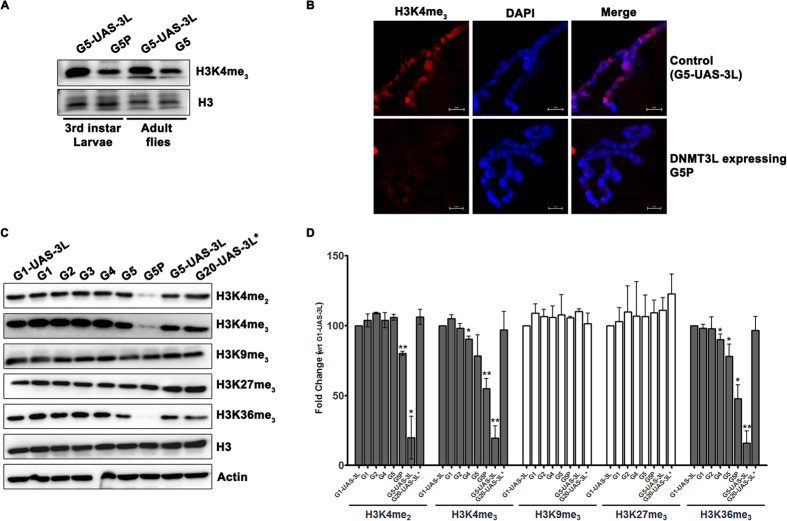
Accumulation of aberrant histone methylation in DNMT3L expressing Drosophila across successive generations.(A) Western blot analysis demonstrating decrease in the levels of the H3K4me3 in 3rd instar larvae or adult flies expressing DNMT3L from the 5th generation as compared to control UAS-3L flies lacking the GAL4 driver. Histone H3 was used as loading control. (B) Immunostaining of Drosophila polytene chromosomes with H3K4me3 antibody. (C) Western blot analysis for the various histone modification as indicated, performed on larvae from the various generations of control and DNMT3L expressing Drosophila larvae. The densitometric scan values for each signal was calculated and is represented graphically in (D) as fold change with respect to the level of the respective histone modification in G1-UAS-3L flies lacking GAL4 driver. G1 and G5-UAS-3L are control larvae without GAL4 driver from G1 and G5 generation respectively. G1 to G5- Tub-3L larvae from the indicated generation. G5P- G5 Tub-3L larvae that had melanotic tumors. G20-UAS-3L* denotes larvae from G20 generation after crossing out of the Tubulin-GAL4 driver. Actin was used as a loading control. The error bars represent Standard Deviation (S.D.). *Indicate significant difference (Student’s t test, *p < 0.05, **p < 0.01).